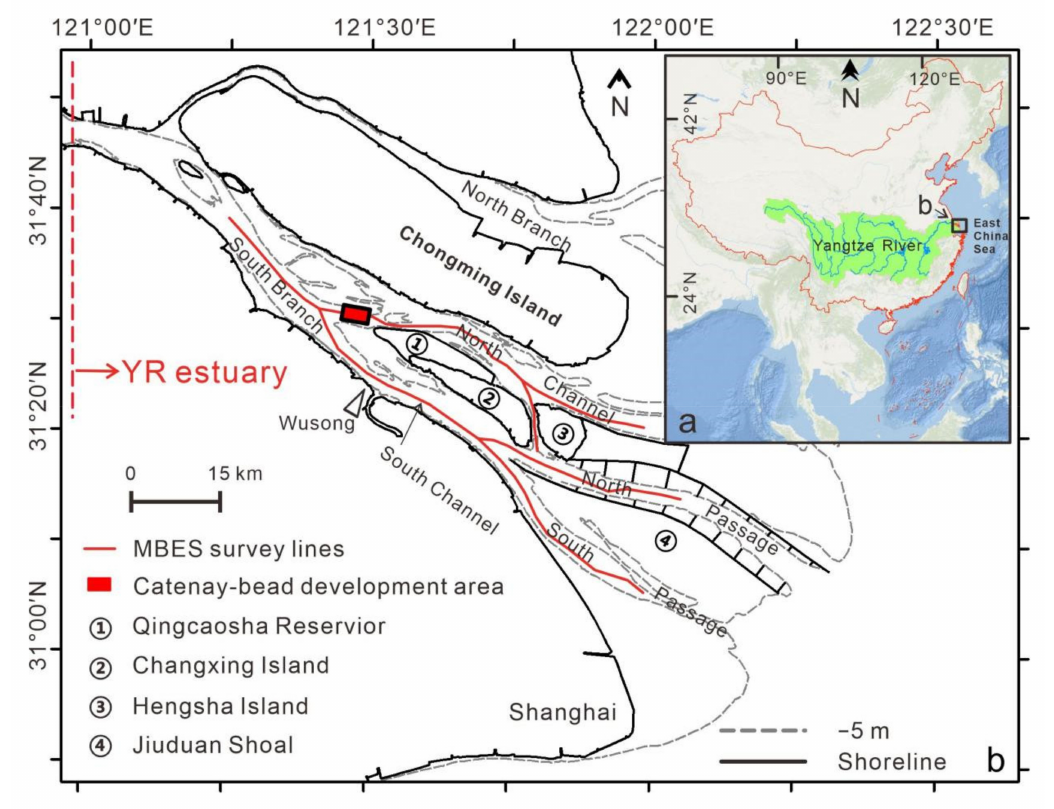
Figure 1. Maps of study area. ( a ) Sketch map of the Yangtze River (YR) Basin. ( b ) Location of the study area and the geomorphic pattern of the YR